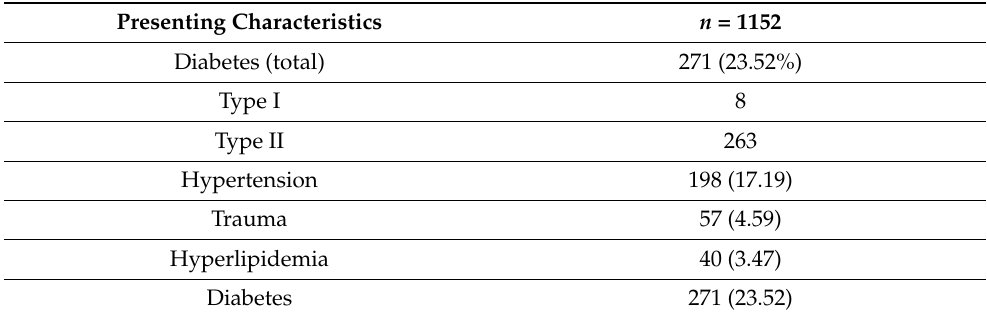
Table 1. Histories and comorbidities, 2016–2021.